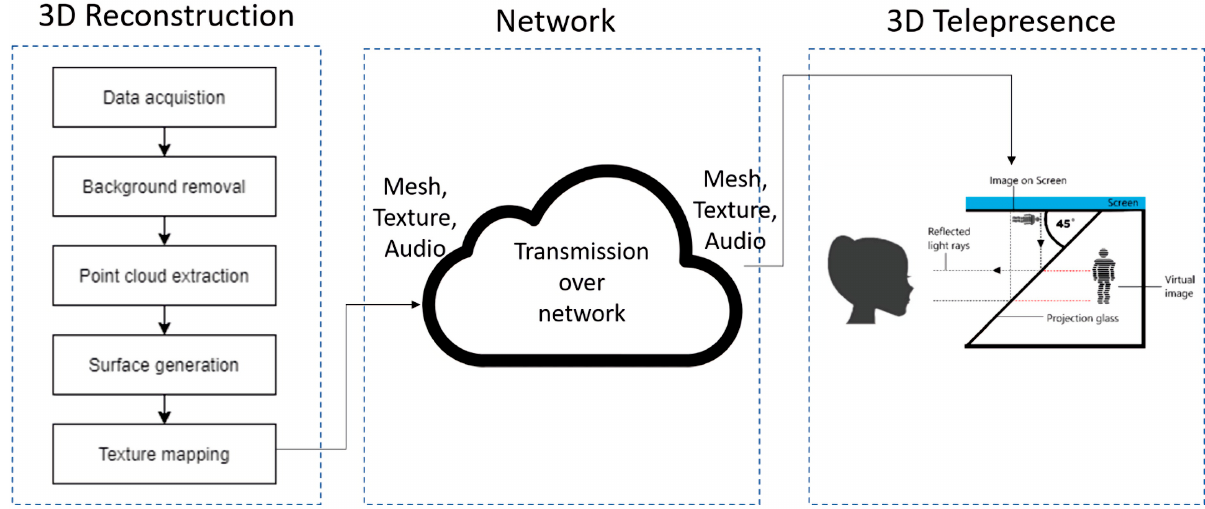
Figure 4. The framework of real-time 3D reconstruction for holographic telepresence.